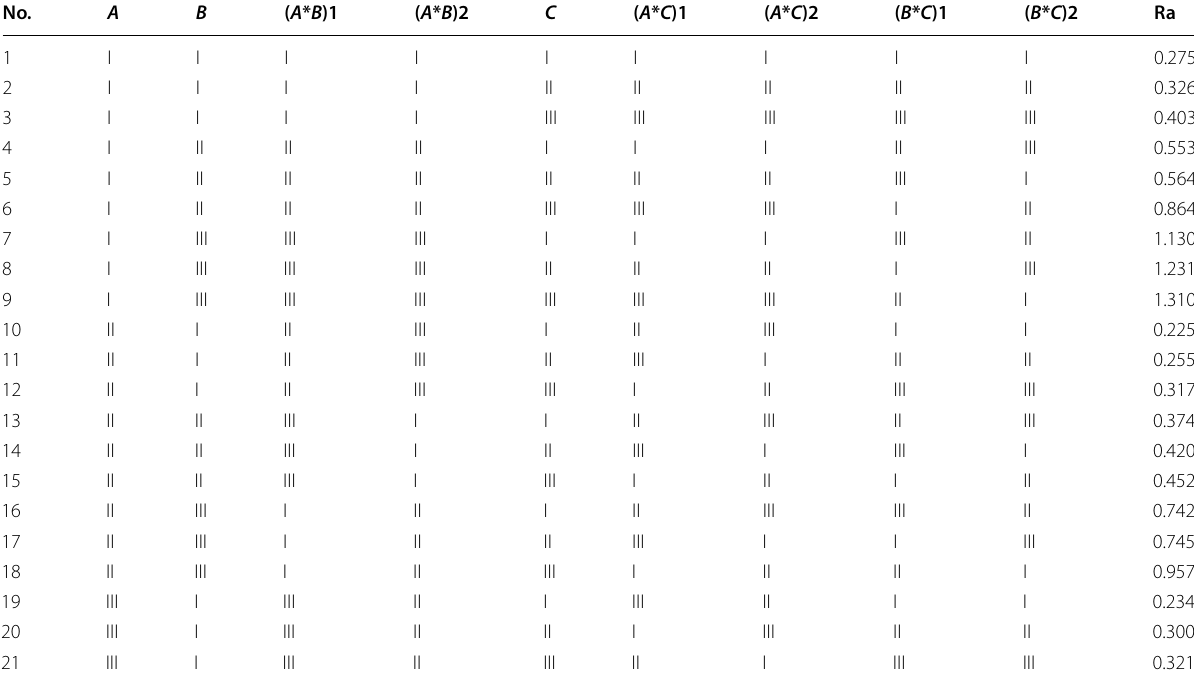
Table 7 Experimental